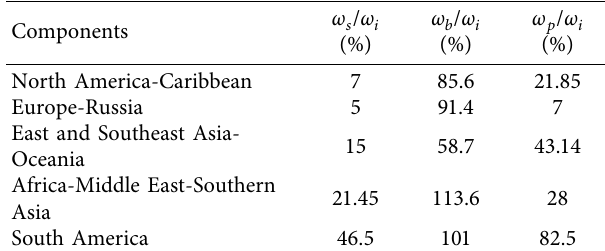
Table 9: Variation of the weighted efciency of the diferent attacks once the component splits from the overall network. ω s, ω b, and ω p, are, respectively, the fraction of the weighted efciency of the LCCs for strength, weighted betweenness, and weighted PageRank attacks. Te weighted betweenness attack does not impact much the efciency of the components compared to the other